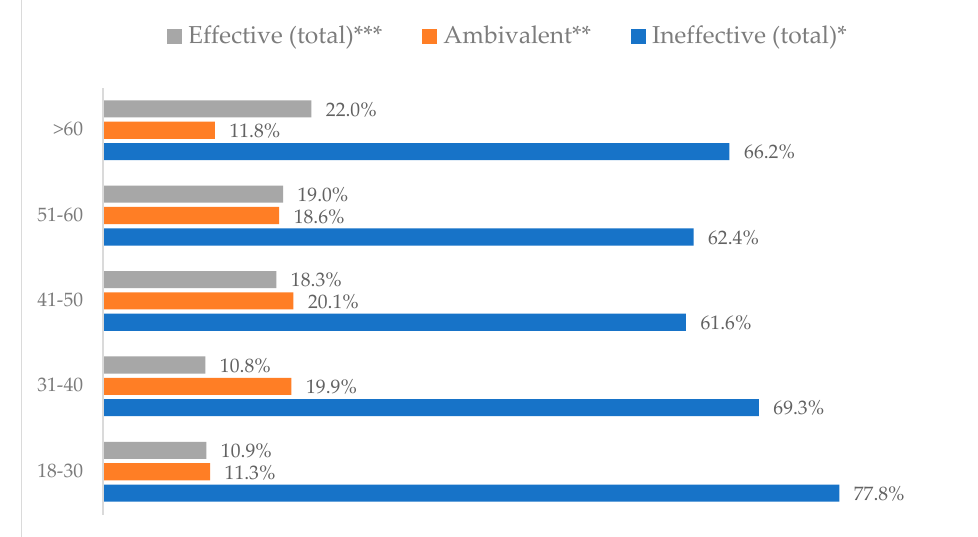
Figure 21. Eating garlic to prevent influenza virus infection by gender ( N = 905). *Sum of responses: completely ineffective, ineffective, rather ineffective; **Response: neither ineffective nor effective; ***Sum of responses: rather effective, effective, completely effective.